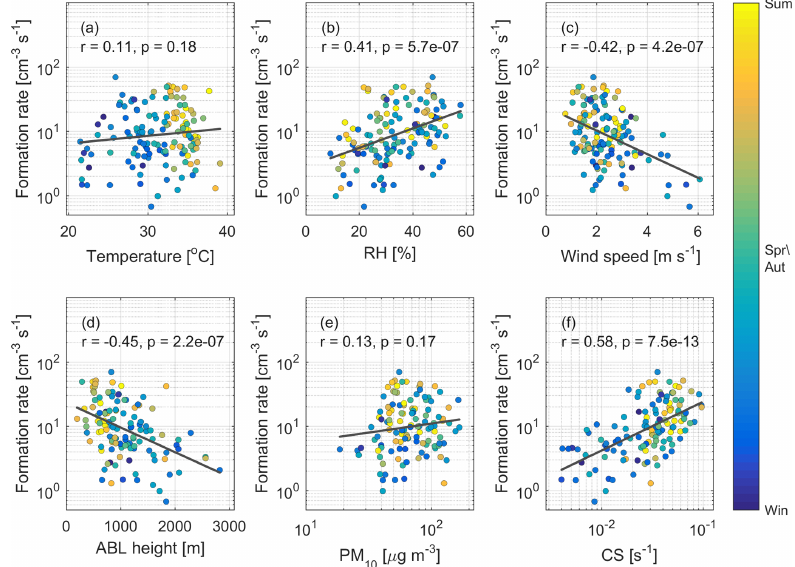
Figure 9. Particle formation rate ( J 7nm ) as a function of (a) temperature, (b) relative humidity, (c) wind speed, (d) atmospheric boundary layer height, (e) PM 10 and (f) the condensation sink. The black lines show the least squares fits to the log-linear ( a, b, c, d ) or log–log ( e and f ) data, and the r and p values denote the Pearson correlation coefficients and their significance levels, respectively. The values on the horizontal axis are event-time averages (from NPF start to NPF end; see Fig. 1). In the case of the CS, the averaging was done for 1h before the NPF start to make sure that the correlation is not influenced by the particles formed in the NPF event itself. The data are colored according to the season, so that summertime is represented by yellow and wintertime by blue